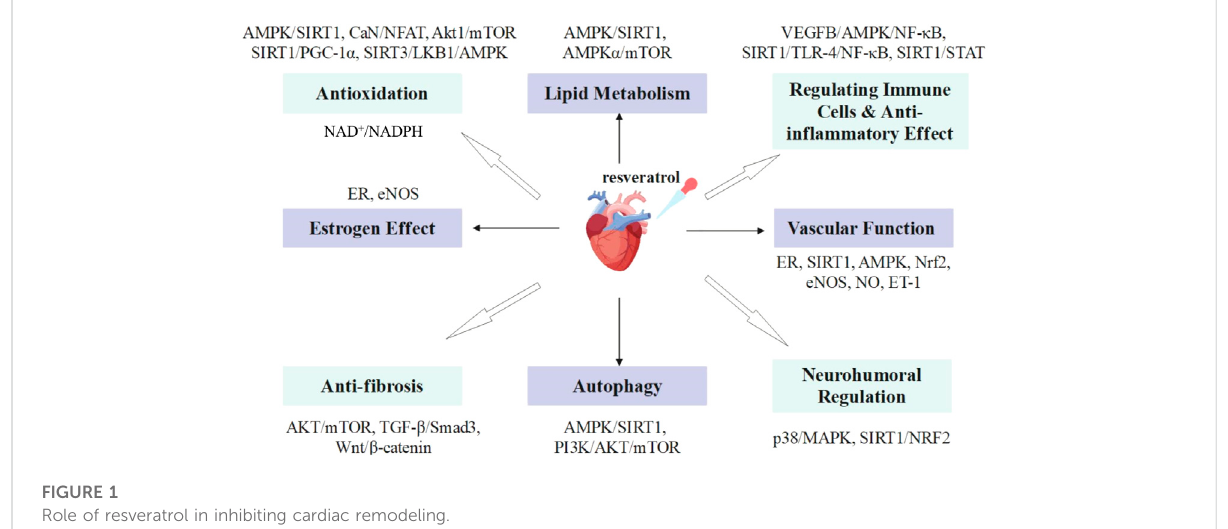
FIGURE 1 Role of resveratrol in inhibiting cardiac